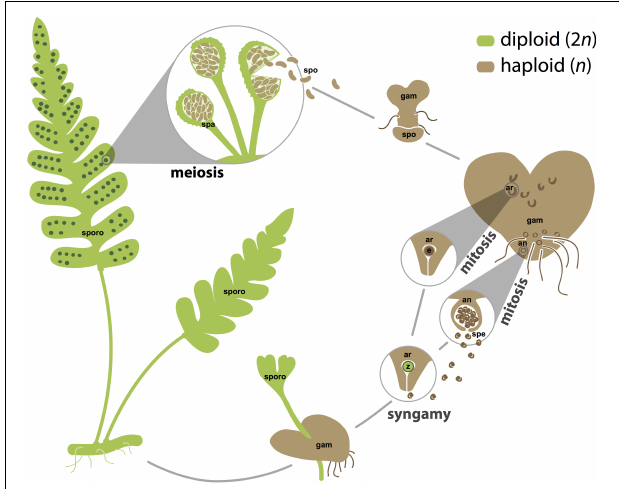
FIGURE 1 | The homosporous fern life cycle. Sporophyte tissues, which are usually but not necessarily diploid, are shown in green. Gametophyte tissues and spores, which are often but not necessarily haploid, are shown in brown. Spores are generated by meiosis in sporangia. Gametes, both eggs and sperm, are generated by mitosis in archegonia and antheridia, respectively. For simplicity, fertilization is depicted between an egg and sperm from the same gametophyte, but fertilization is also likely to occur between gametes from different gametophytes that are derived from the same or different sporophytes. an, antheridium; ar, archegonium; e, egg; gam, gametophyte; spa, sporangium; spe, sperm; spo, spore; sporo, sporophyte; z, zygote. Images are not to